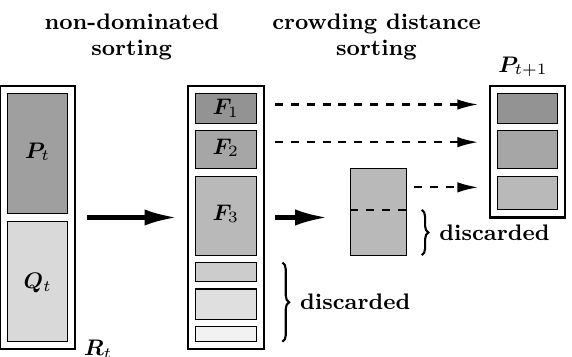
Figure 2. NSGA-II: The parental population P t and the offspring population Q t are combined to a population R t . The members of R t are subsequently assigned to the fronts F 1 to F n according to their non-domination and sorted with respect to the crowding distance. The parental population of the following generation P t + 1 is created from the most fit members of R t